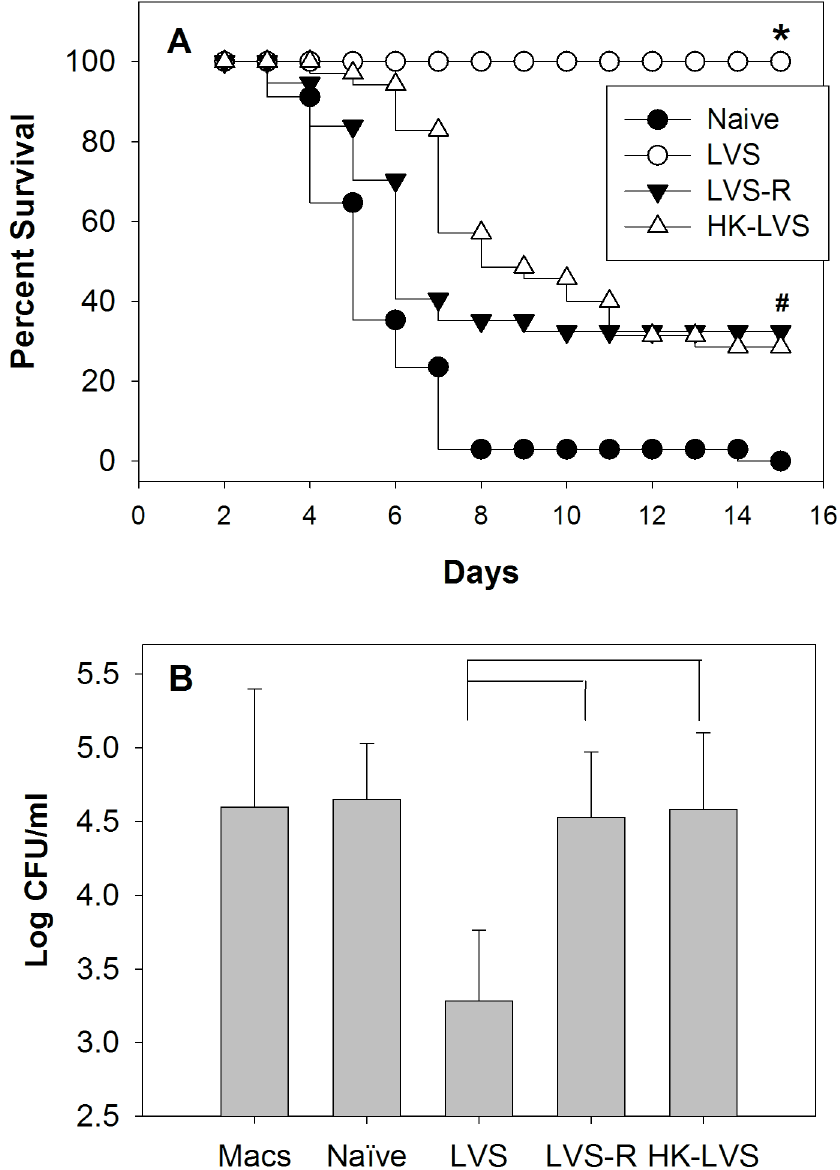
Fig 2. Rat PBLs from differentially vaccinated rats control intramacrophage Francisella growth in a pattern that reflects vaccine efficacy. Groups of 6 Fischer 344 rats were vaccinated with LVS, LVS-R, HK-LVS, or PBS (naïve) for a total of 31–37 rats per group, and challenged 5 weeks later i.t. with 10 3 CFU F . tularensis . Percent survival after one month is shown with data combined from five independent challenge experiments (Panel A). (cid:3) indicates significantly greater survival compared to naïve rats or rats vaccinated with LVS-R and HK-LVS; # indicates significantly greater survival compared to naïve rats. There was no significant difference between survival of LVS-R and HK-LVS vaccinated rats. In parallel, BMM F from Fischer 344 rats were infected with LVS (Macs alone), and co-cultured with PBLs obtained 5 weeks after vaccination from 3 remaining naïve or vaccinated Fischer 344 rats, as indicated. After two days of co-culture, BMM F were lysed to evaluate the recovery of intracellular bacteria. Values shown are the mean numbers of CFU/ml ± SD of viable bacteria for five independent experiments of similar design and outcomes (Panel B). Brackets indicate a significant difference ( P < 0.05) between the recoveries of bacteria from macrophages in co- cultures. There was no significant difference between the recoveries of bacteria from co-cultures using LVS-R or HK-LVS-immune